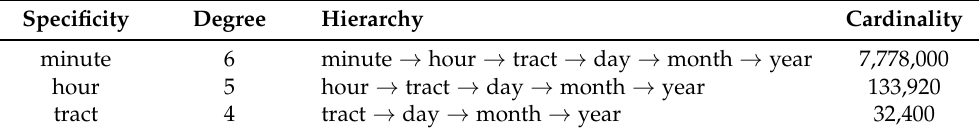
Table 4. Temporal granularity